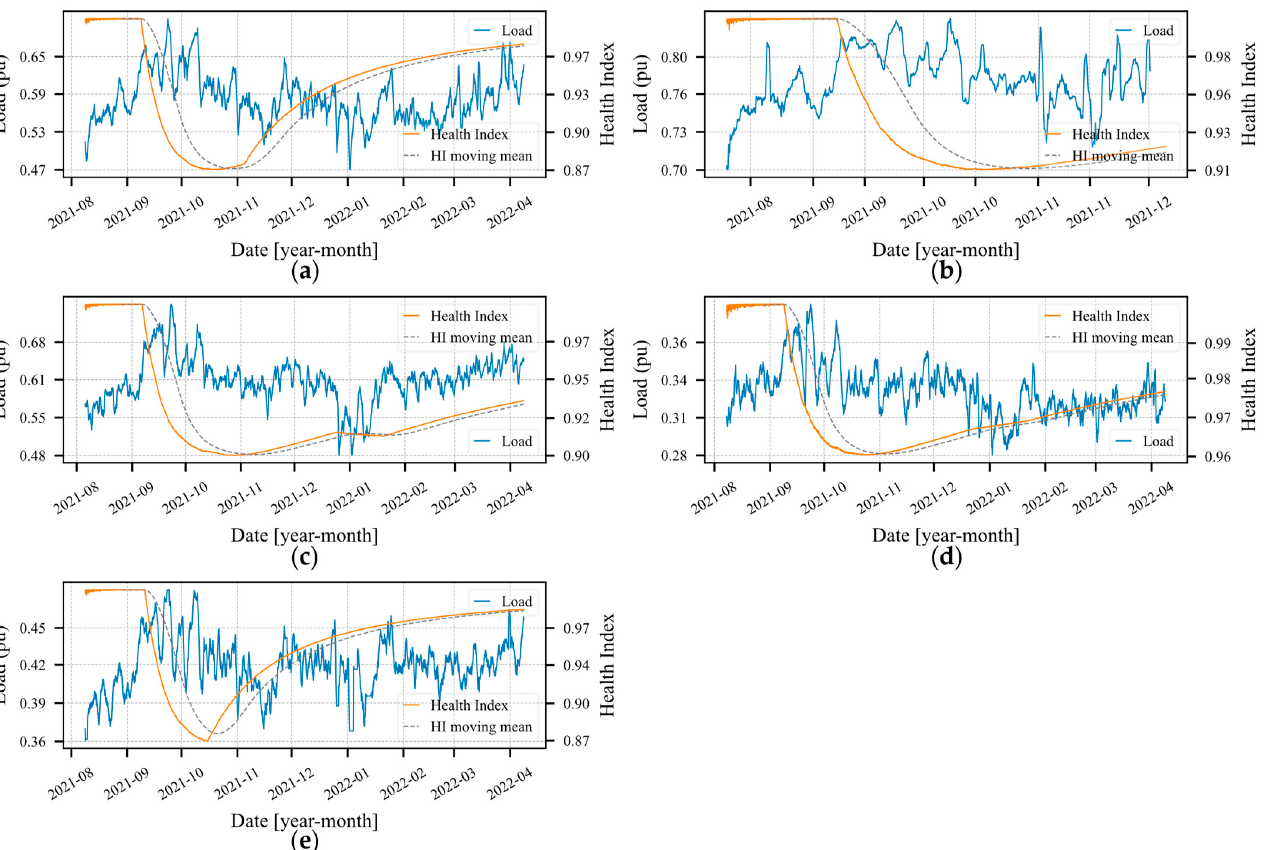
Figure 11. Health index and loading of the transformer (sum of the currents for the three phases). ( a – e ) show the evolution of the HI during the case study, further highlighting the 20 days moving average of the HI .